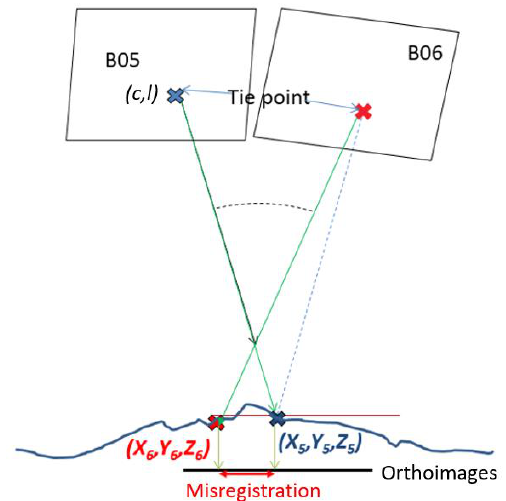
Figure 25. Multi-spectral misregistration computation principle. Monitoring was performed on eight specific sites with good correlation and few clouds. These sites are, as for the multi-temporal registration performance, spread around the world (North and South America, Australia and Israel).